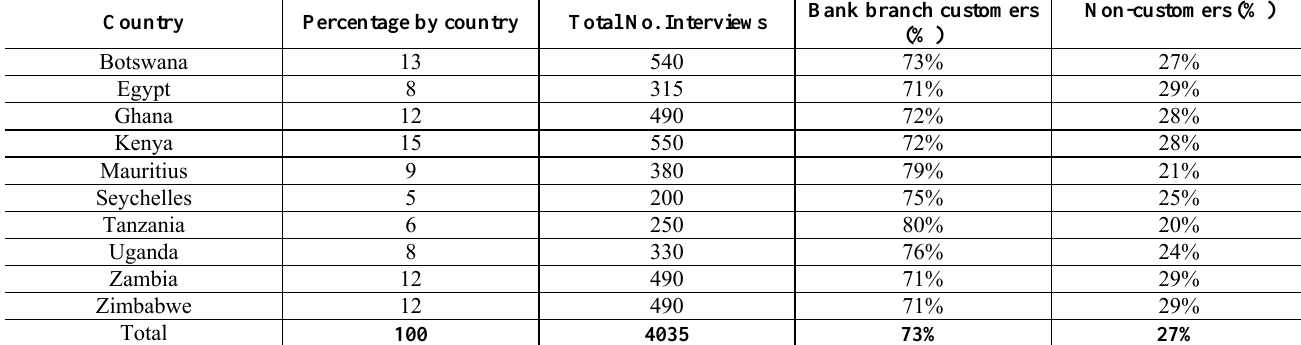
Table 3: Sample size by country